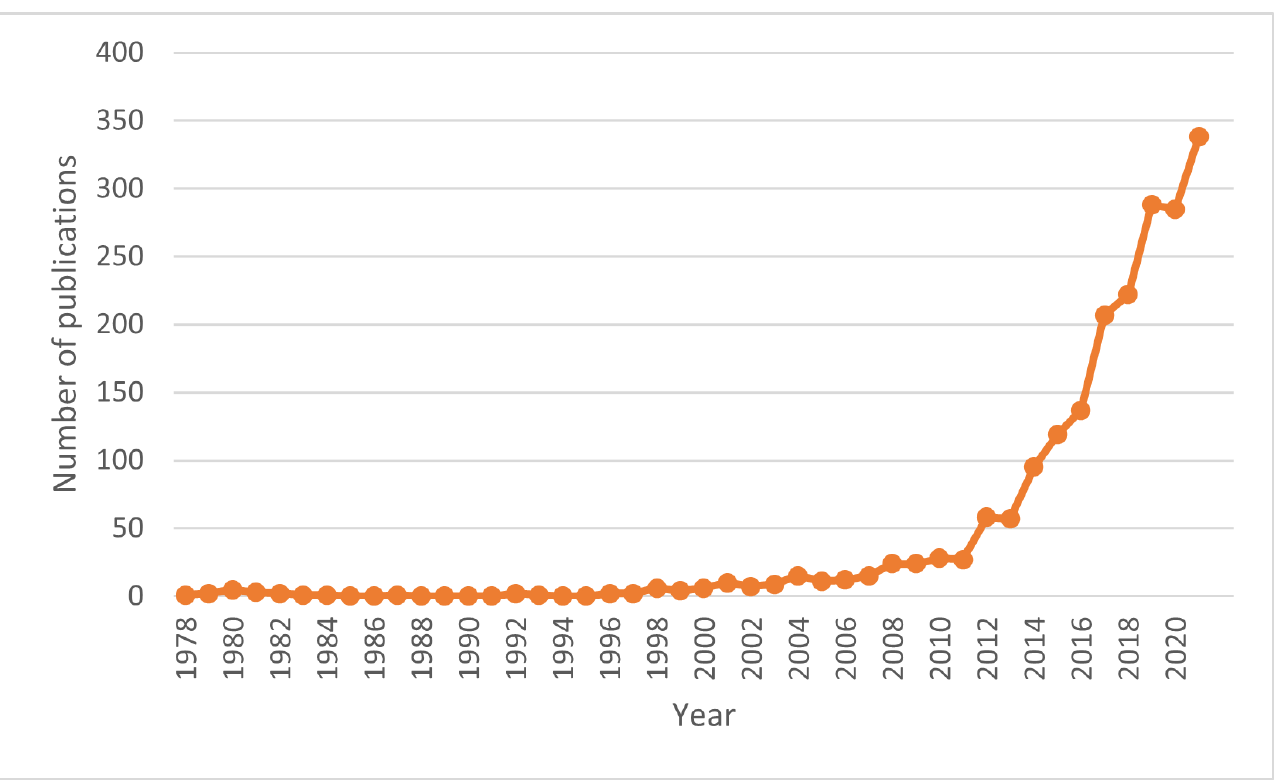
Figure 5. Evolution of Scopus-indexed articles for carsharing or